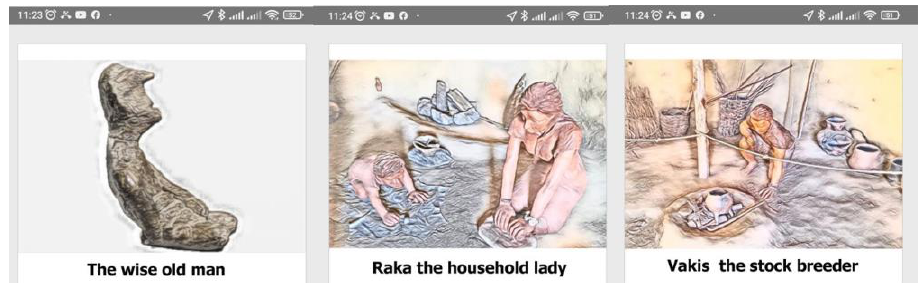
Figure 16. Characters that give the player clues for solving the crime